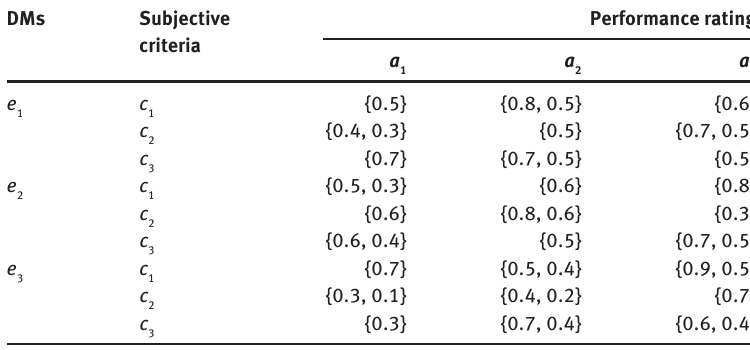
Table 1: Decision Matrices D ( k ) Provided by e DMs